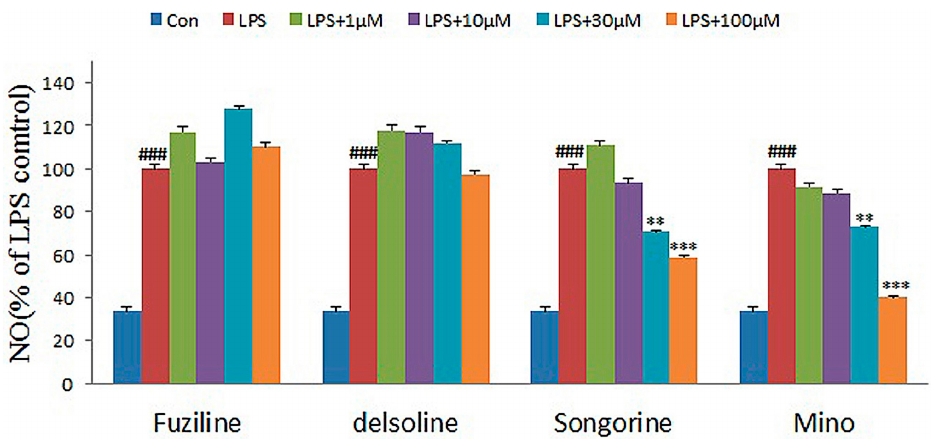
Figure 6. Anti-inflammatory activity assay of the compounds (Fuziline, delsoline, Songorine and Mino) in N9 microglial cells. Each bar represents the mean ± SE of three independent experiments. One-way ANOVA adjusted by Dunnett’s test was used for statistical analysis (SPSS 15.0 software, SPSS). ### p < 0.001 compared with control group, ** p < 0.01 and *** p < 0.001 compared with LPS group.